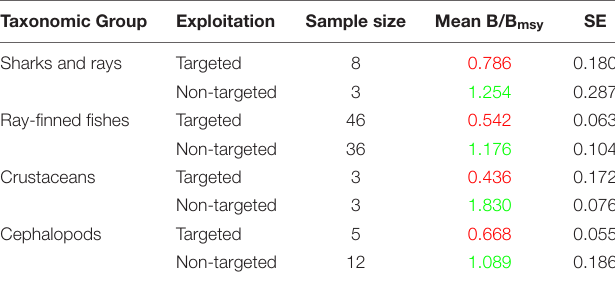
TABLE 2 | The mean ( ± SE) B/B msy of targeted (prime and alternative stocks) and non-targeted (by-catch and discard stocks) fish and invertebrate stocks of the Aegean